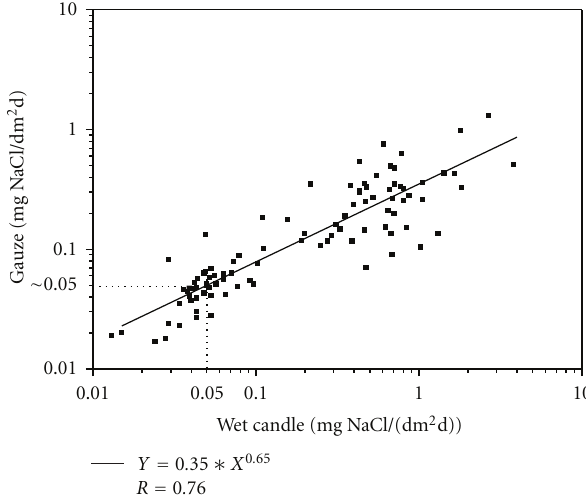
Figure 4: Relationship between measurements obtained by the wet candle method and the gauze